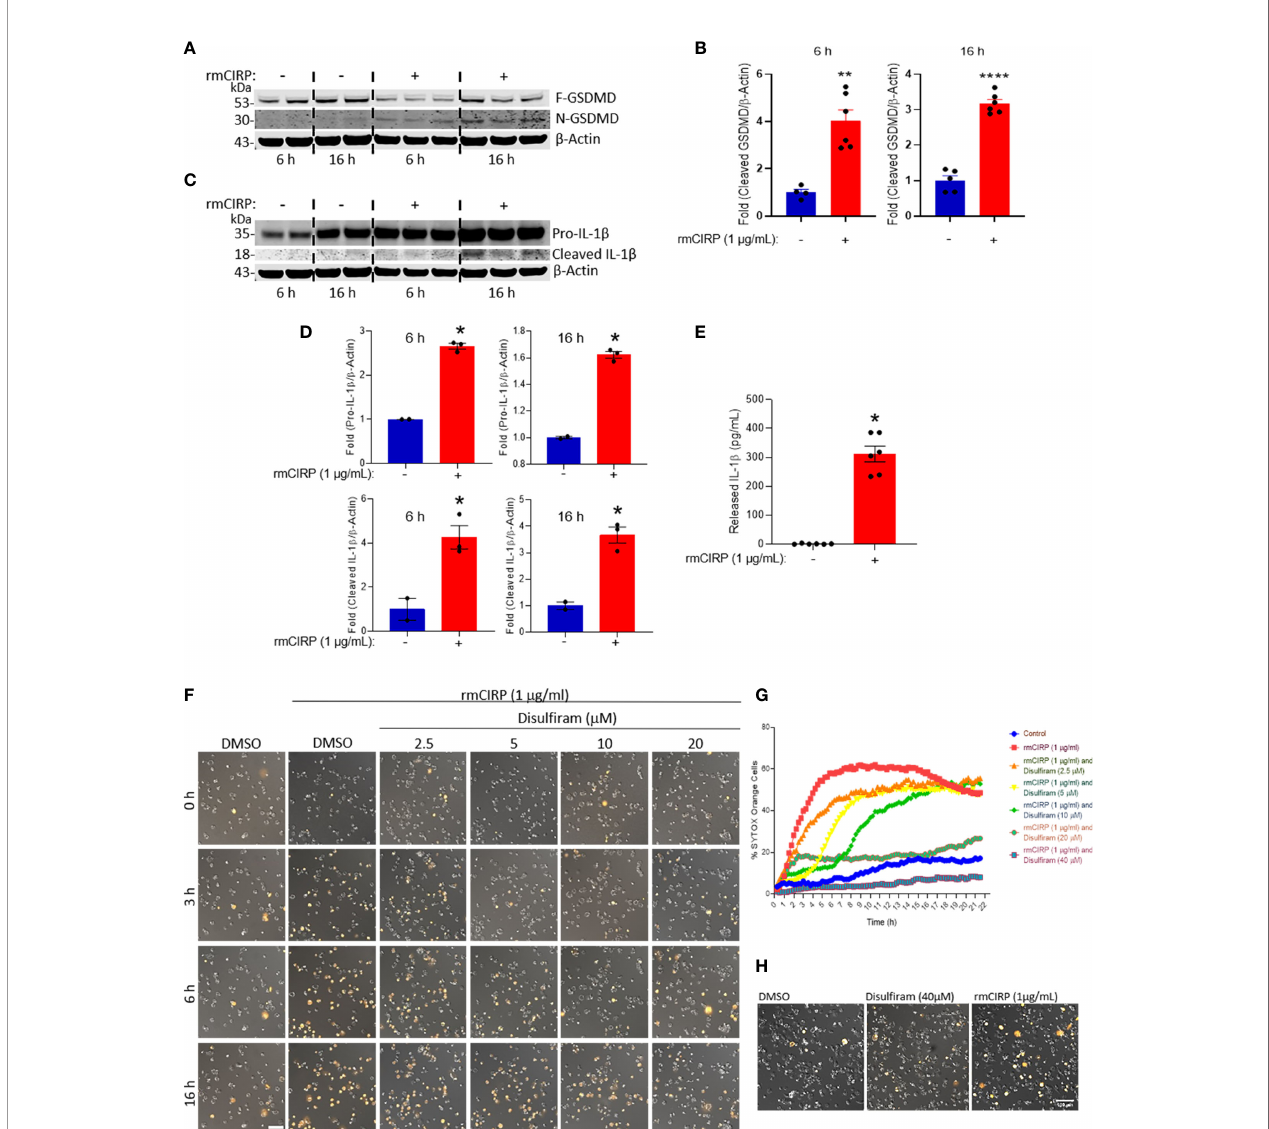
FIGURE 5 | eCIRP induces MET formation through GSDMD activation in THP-1 cells. (A) rmCIRP (1 µg/ml) treatment increases the proteolytic cleavage of GSDMD, which indicates the activation of GSDMD. Lysates of THP-1 cells with or without rmCIRP treatment for 6 or 16 h were subjected to the Western blotting with antibody speci fi c to cleaved N-GSDMD fragment, then probed with antibody speci fi c to full-length GSDMD and b -actin after stripping the membrane. Full gel images are shown in Supplementary Figure S3 . (B) The Western blot shows a signi fi cant increase of pore-forming N-GSDMD fragments after rmCIRP treatment. The intensity of the bands detected was quanti fi ed by densitometry. Student t -test: **p <0.01 vs. PBS (without rmCIRP) at 6 h, ****p <0.001 vs. PBS (without rmCIRP) at 16 h. (C) Lysates of THP-1 cells with or without rmCIRP treatment for 6 or 16 h were subjected to the Western blotting with antibody speci fi c to human IL-1 b , that detect pro- (35 kD) and mature IL-1 b (18 kD). Full gel images are shown in Supplementary Figure S3 . (D) The intensity of the bands detected was quanti fi ed by densitometry. Student t -test: *p <0.05 vs. PBS (without rmCIRP) at 6 h, *p <0.05 vs. PBS (without rmCIRP) at 16 h. (E) THP-1 cells were treated with rmCIRP for 16 h and then cell culture supernatants were collected. IL-1 b levels in the culture supernatants were detected by ELISA. Student t -test: *p <0.05 vs. PBS (without rmCIRP) at 16 h. (F) Pretreatment of disul fi ram at various doses suppresses the cell permeabilization and the formation of extracellular traps by rmCIRP in THP-1 cells. The inhibition effect of disul fi ram is dose-dependently increased. Cells were treated with disul fi ram and SYTOX Orange (0.6 µM) for 30 min. THP-1 cells were subjected to the time-lapse live cell imaging immediately after the treatment of rmCIRP (1 µg/ml). Scale bar, 100 µm. (G) The inhibitory effect of disul fi ram on eCIRP- induced MET formation is dose-dependently increased. The inhibitor disul fi ram was pretreated 30 min before rmCIRP (1 µg/ml), and the cells were subjected to the time-lapse live-cell imaging immediately after the treatment of rmCIRP. The effect of disul fi ram was quanti fi ed by counting the cells positive to SYTOX Orange. (H) Cell viability assay after disul fi ram treatment using SYTOX Orange. THP-1 cells were treated with DMSO, Disul fi ram only at a concentration of 40 µM, and rmCIRP (1 µg/ml), separately. Cells were simultaneously added with 0.6 µM of SYTOX Orange were subjected to the time-lapse live-cell imaging. After 16 h, microscopic images were acquired. Representative images are shown. Scale bar, 100